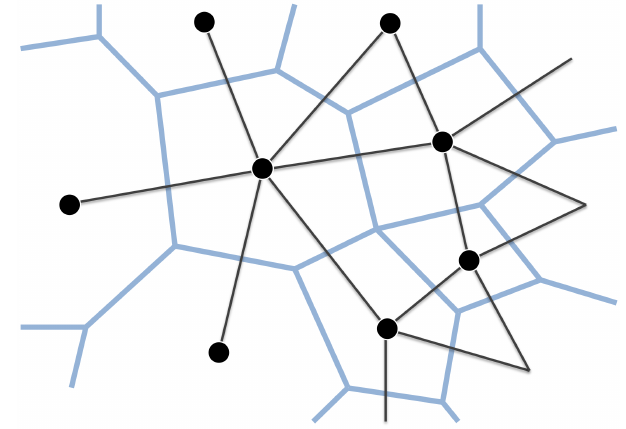
Figure 1. An example node graph describing an unstructured grid (blue lines), where nodes are co-located with volume center-point locations (solid circles) and edges connect adjacent volumes.